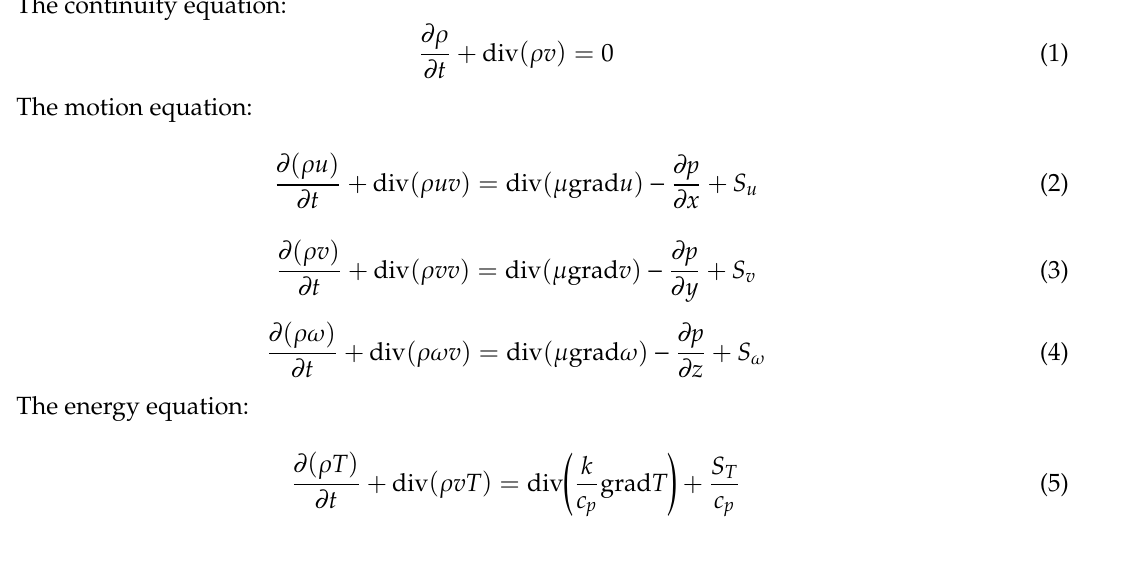
Figure 4. Mesh of the computational domain.